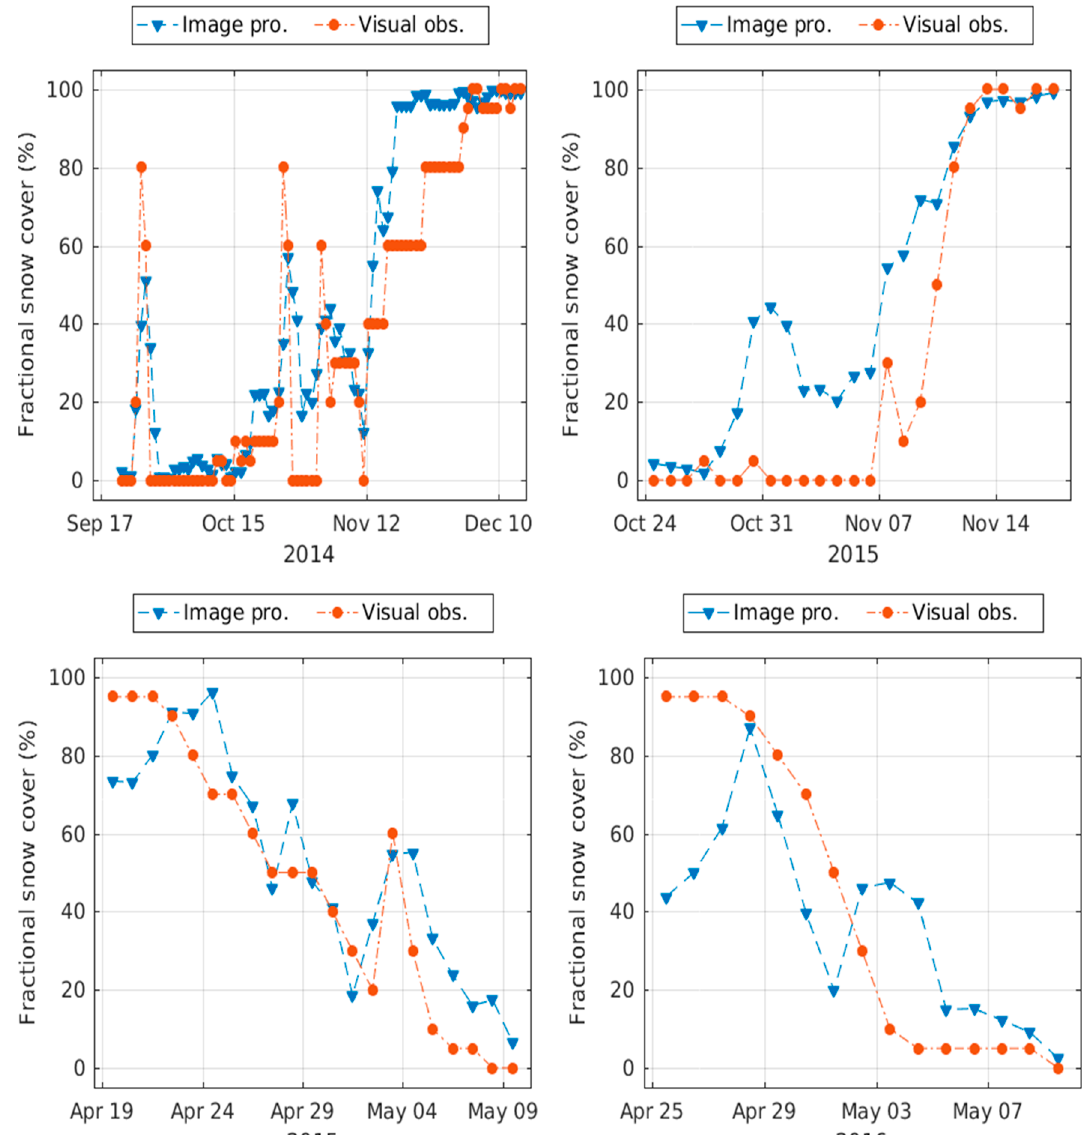
Figure 9. Sodankylä ground camera early season ( top ) and melting season ( bottom ); comparisons of image processing results and visual observations.